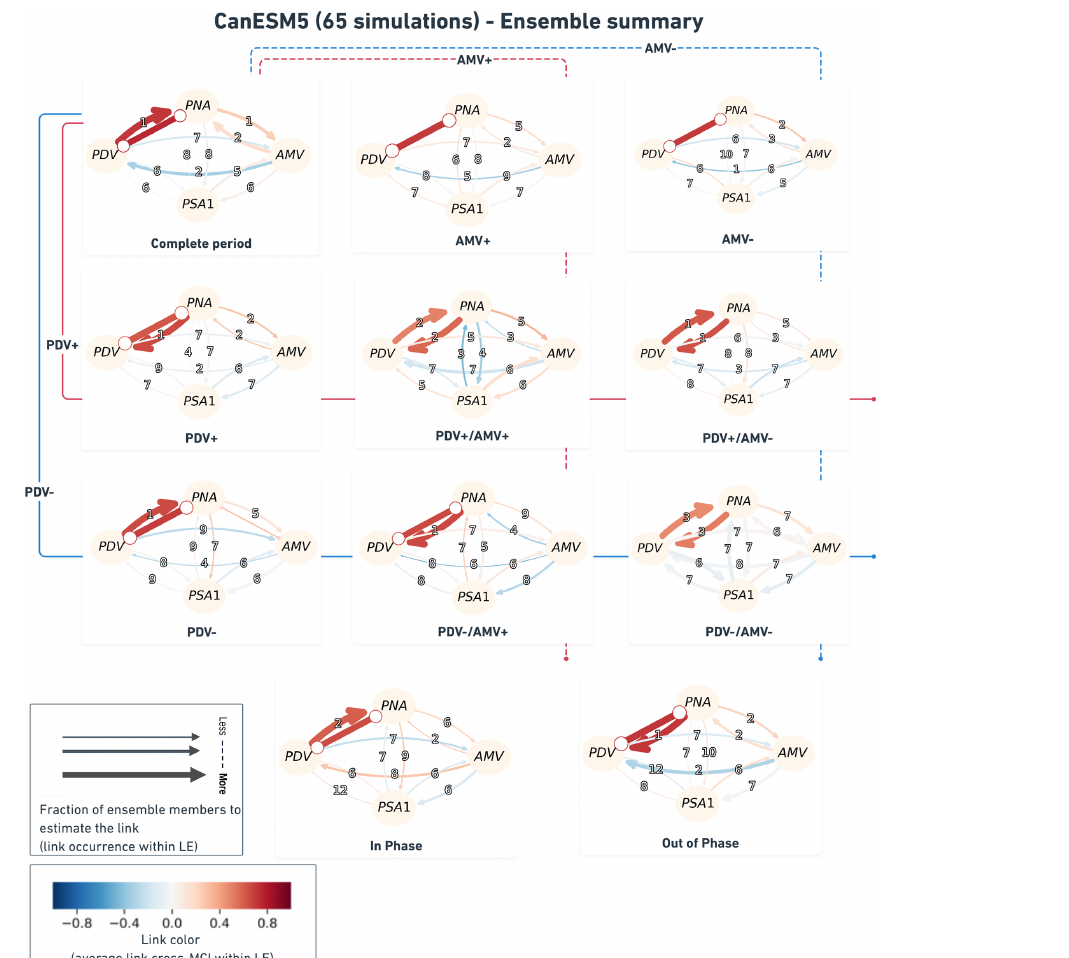
Figure 7. Ensemble summary of the CanESM5 LE model. Similar to Fig. 5 but aggregating causal networks from 65 realizations. The link width here shows the fraction of ensemble members that feature that link the relative to the total ensemble size (here, 65); i.e., the thicker the link, the more ensemble members were found to estimate it during that specific regime. Link colors here translate the mean cross-MCI value among the ensemble members that estimated such a link (color bar on the lower left). Links of very light color are those on which ensemble members show little agreement regarding their partial-correlation sign. The link labels indicate the average time lag (rounded to the nearest integer) at which the link is estimated among the fraction of ensemble members that find such a